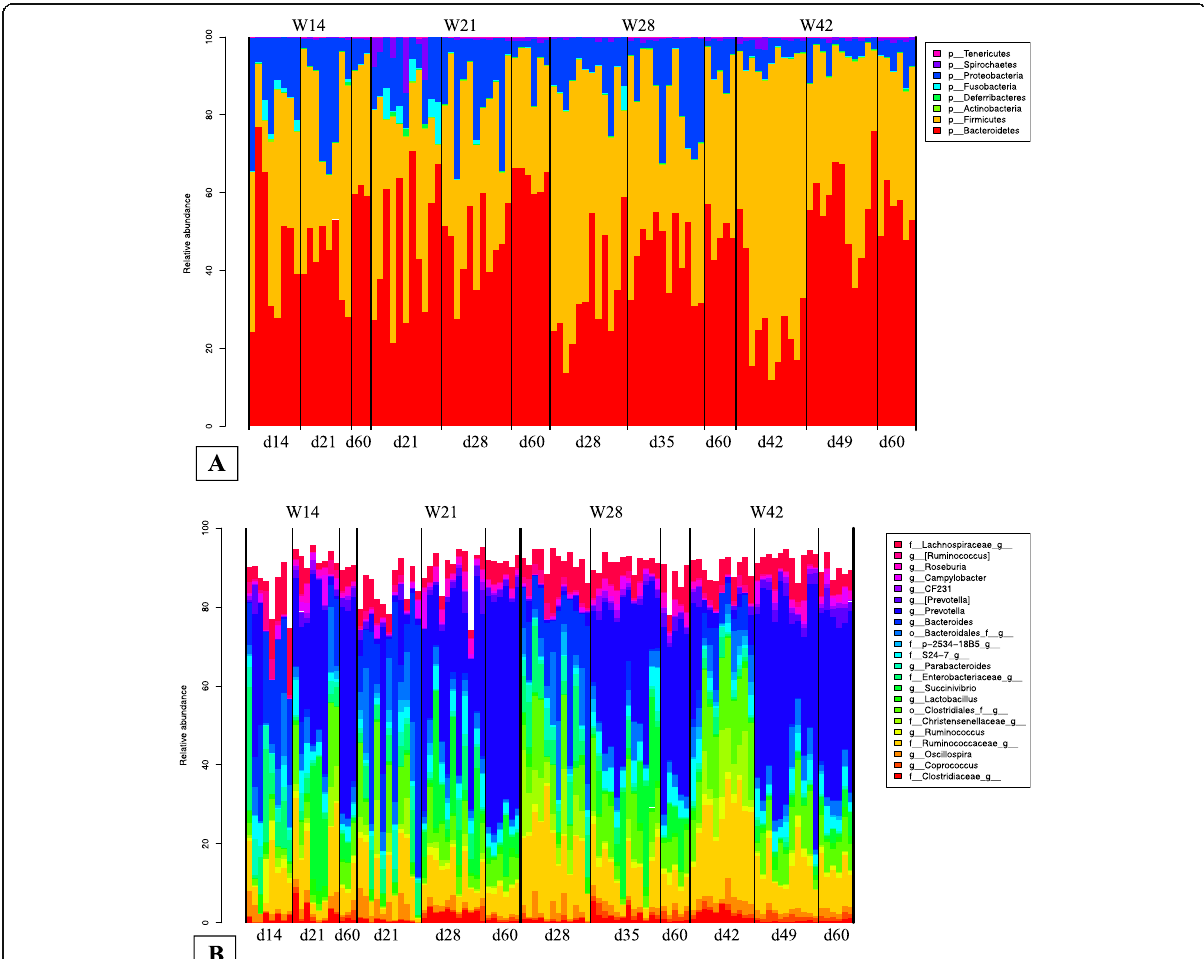
Fig. 2 Relative abundance of the different microbial phyla ( a ) and genera ( b ) at each sampling point for every individual pig in each weaning group. Only genera present in at least 20% of the piglets are